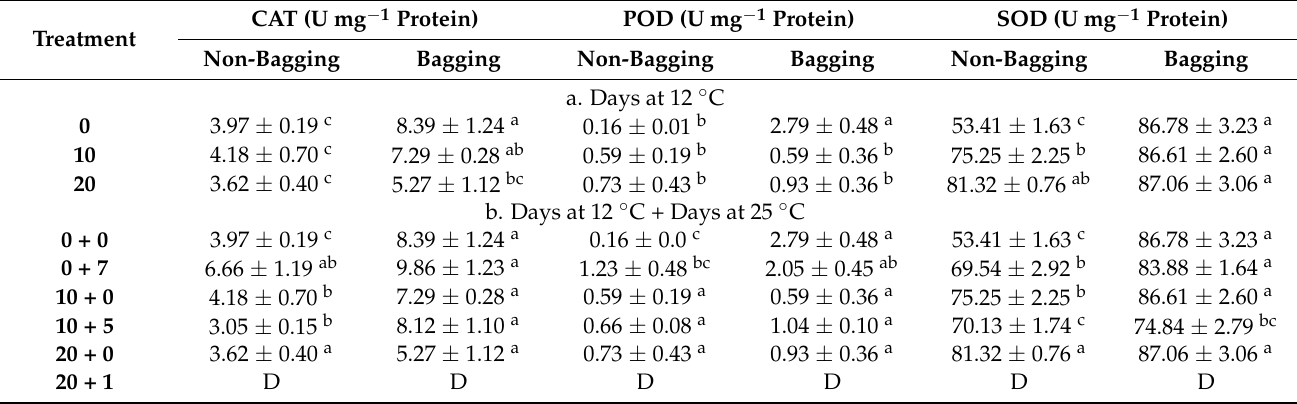
Table 4. Effect of on-tree fruit bagging treatments on catalase (CAT), peroxidase (POD) and superoxide dismutase (SOD) activities in mango fruit during cold storage intervals and under ambient conditions. Values are means of triplicates ± SD. Different letters in superscripts indicate significant differences according to the LSD test at p ≤ 0.05. D, decayed fruit hence no tests were